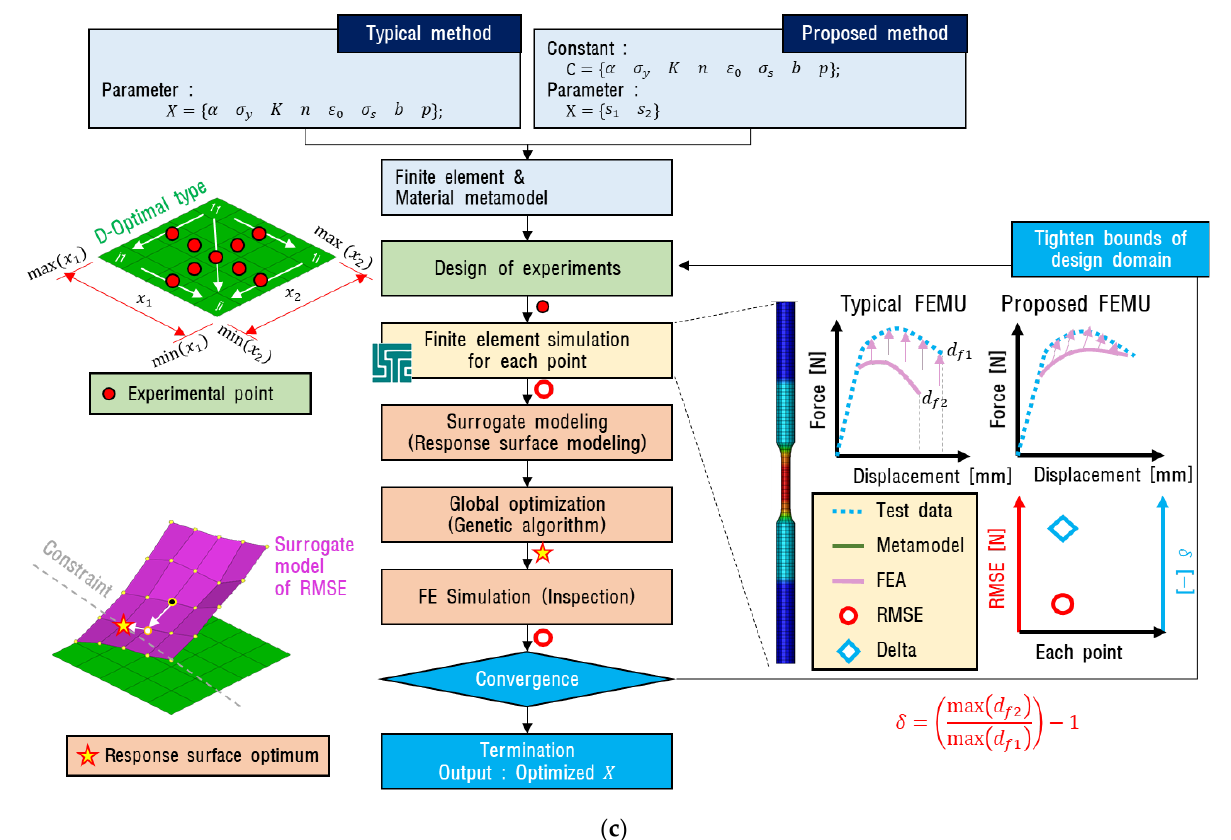
Figure 10. Inverse method procedure: ( a ) Typical method (metamodel-based simulation optimiza- tion with one-time initialization of variables); ( b ) Proposed method (metamodel-based simulation optimization using CFT); ( c ) Concept diagram of inverse method procedure.